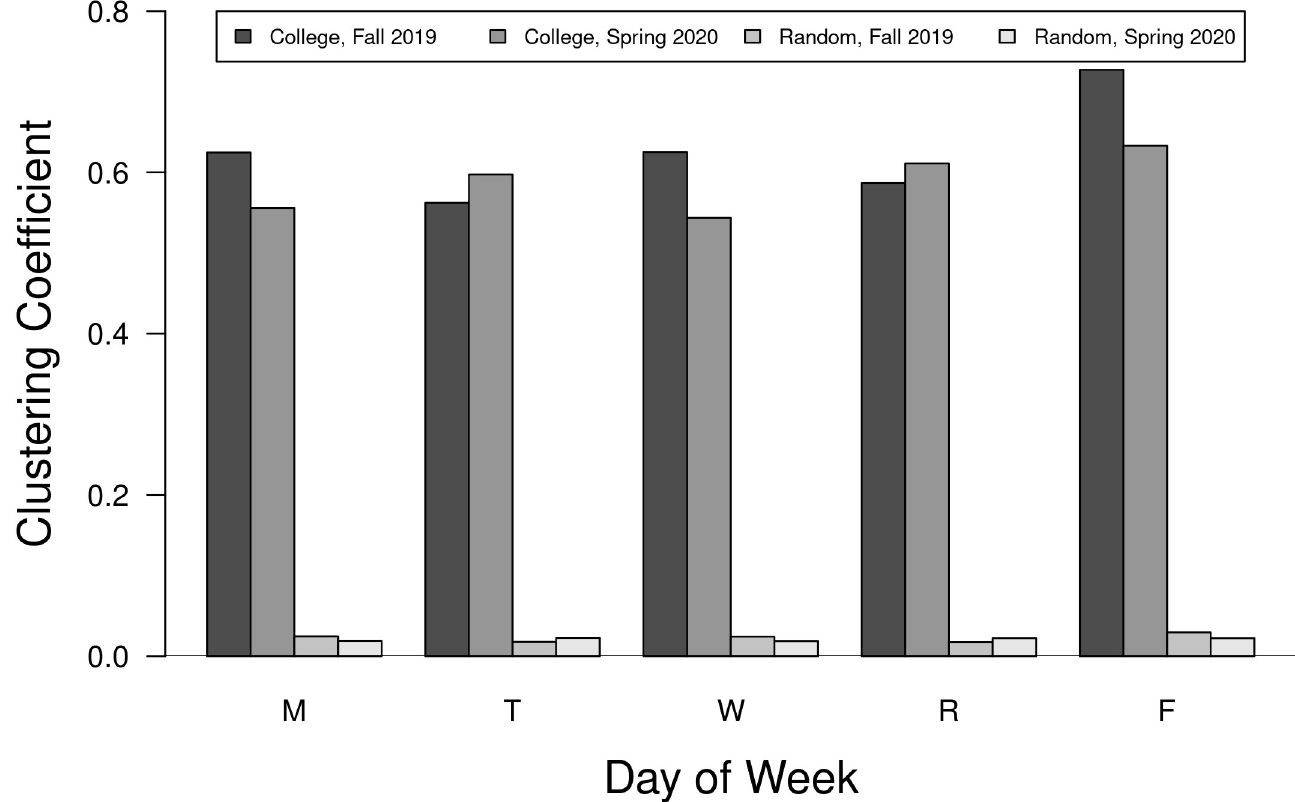
Fig 6. Clustering coefficients for weekday college and random networks. The global clustering coefficients (transitivity) for the college and one rendition of the paired random networks based on the same number of vertices and edges.